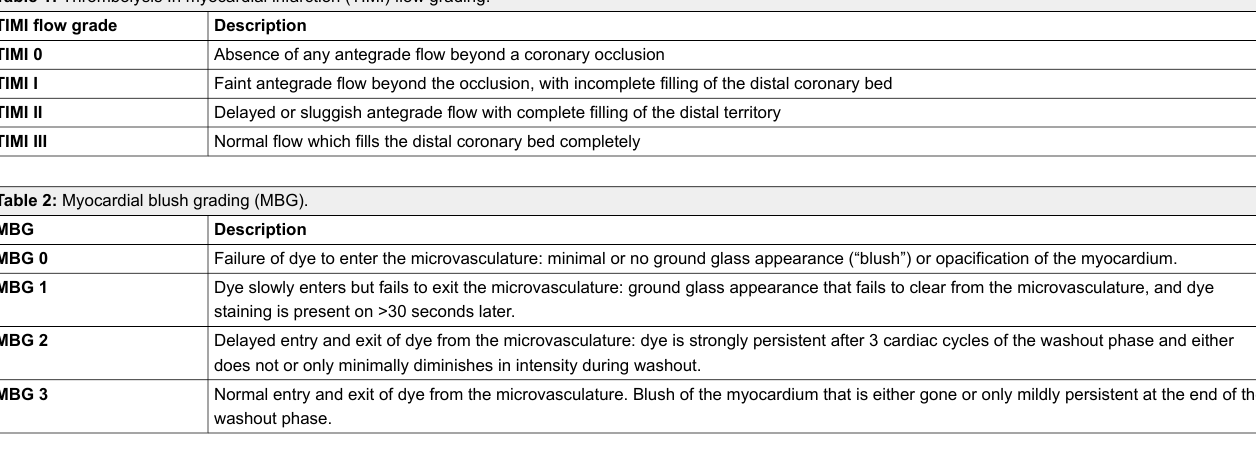
Table 1: Thrombolysis In myocardial infarction (TIMI) flow grading. TIMI flow grade